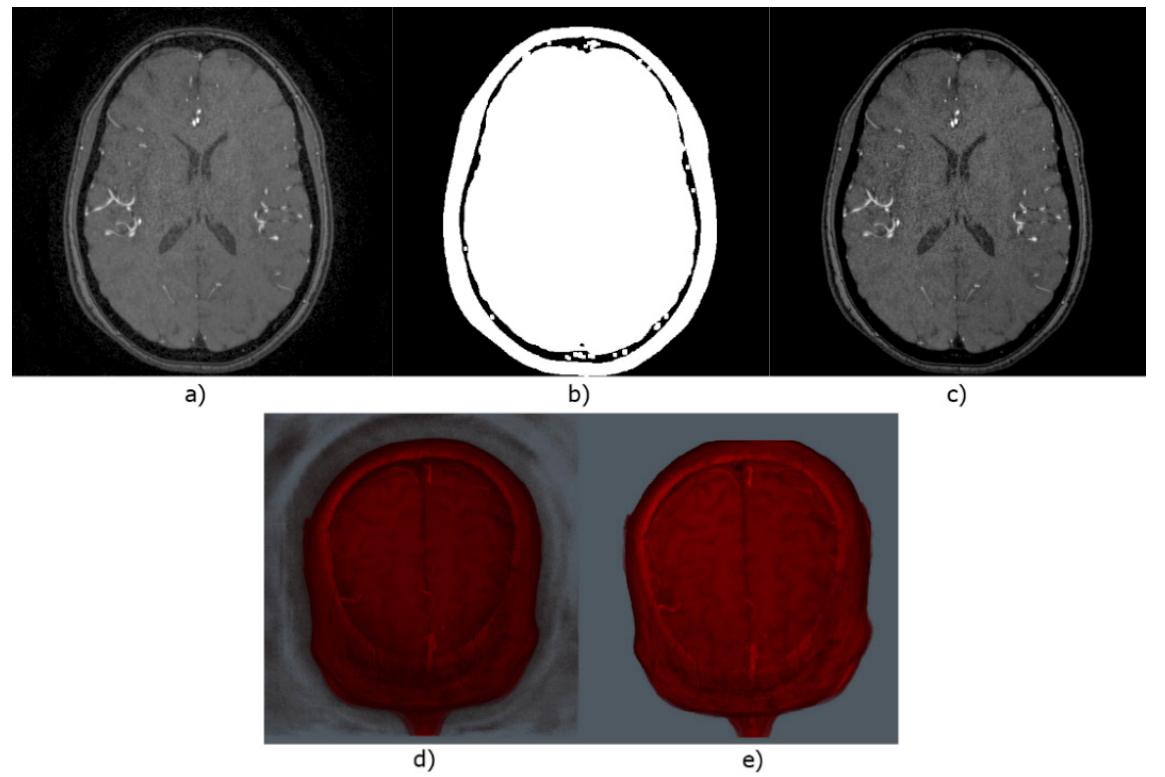
Figure 2. Comparison for original and preprocessed images. ( a ) Sample image from an MRA volume. ( b ) Generated mask from ( a ). ( c ) Output image from multiplying ( a , b ). ( d ) Sample volume without preprocessing. ( e ) Output volume from applying the corresponding mask for each image within it.